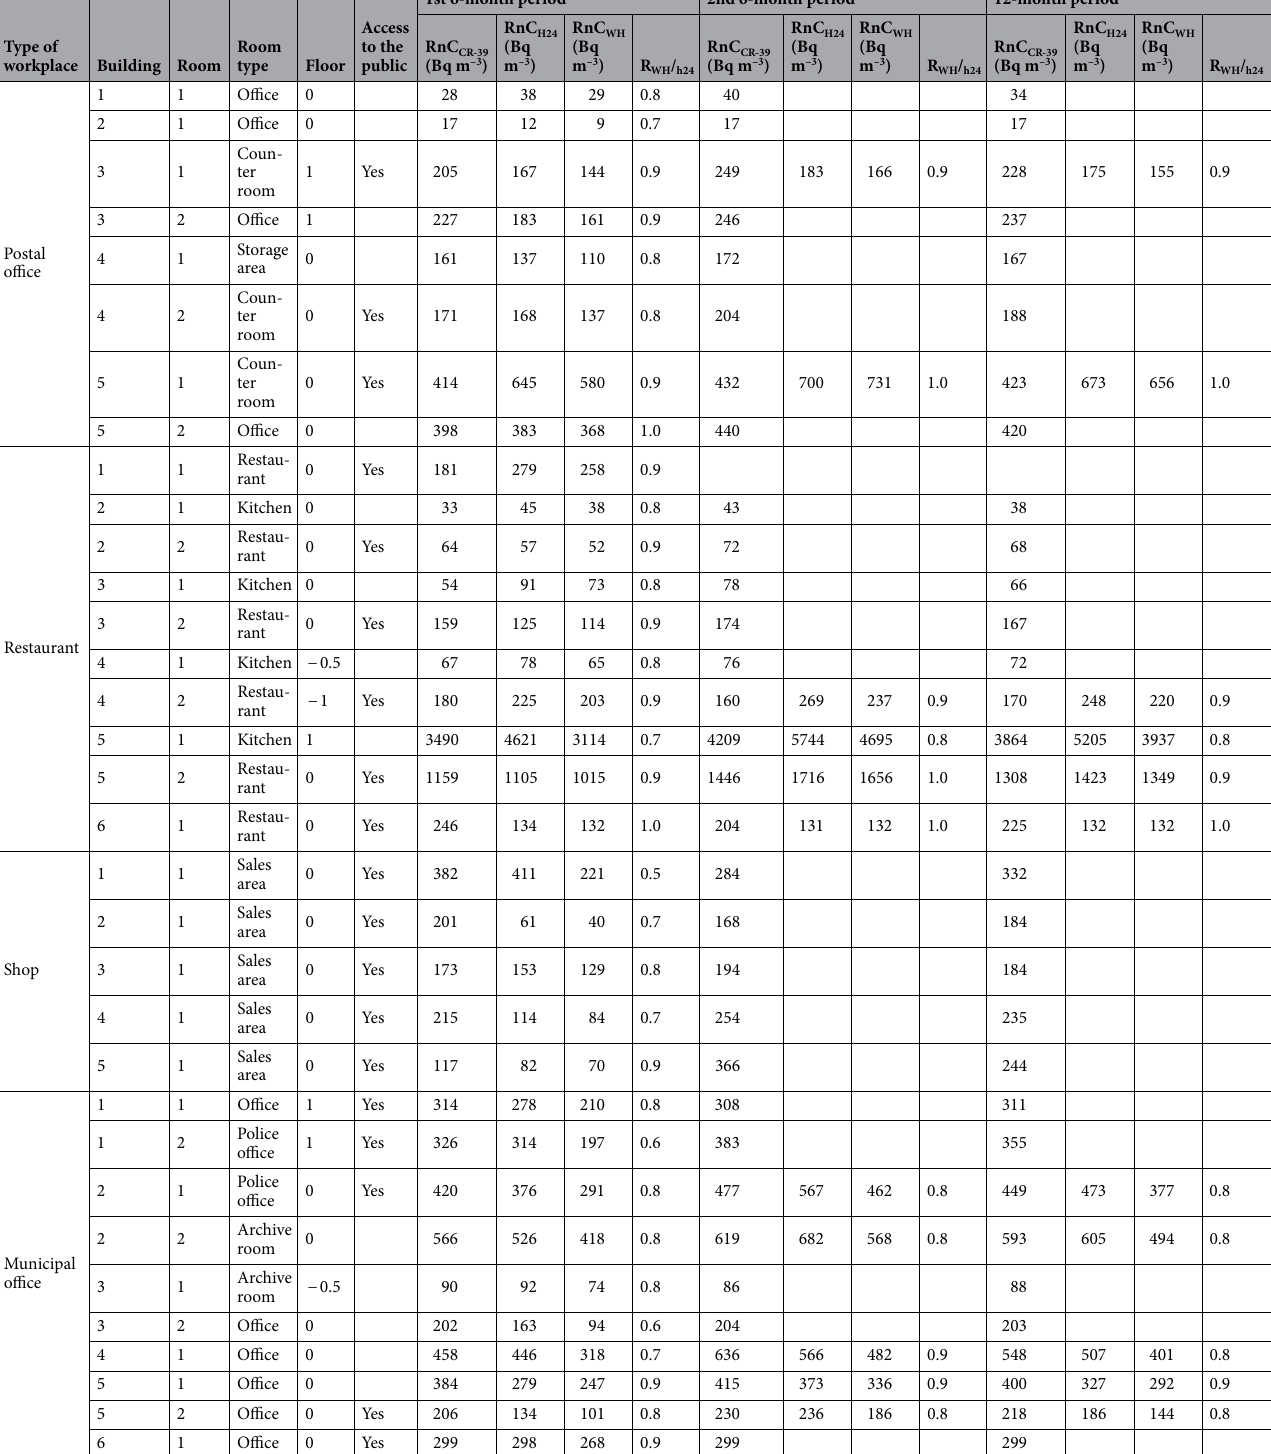
Table 2. Results of the average radon concentration measurements (over two 6-month periods and over 1 year) performed using passive radon devices (RnC CR-39 ) and active ones integrating radon levels over the all the days (RnC H24 ) and over the working hours (RnC WH ). The uncertainties for RnC H24 and RnC WH (not reported in the table) are of the order of 10% (k = 1). Legends for floor: 0 = ground floor; − 0.5 = basement; 1 = first